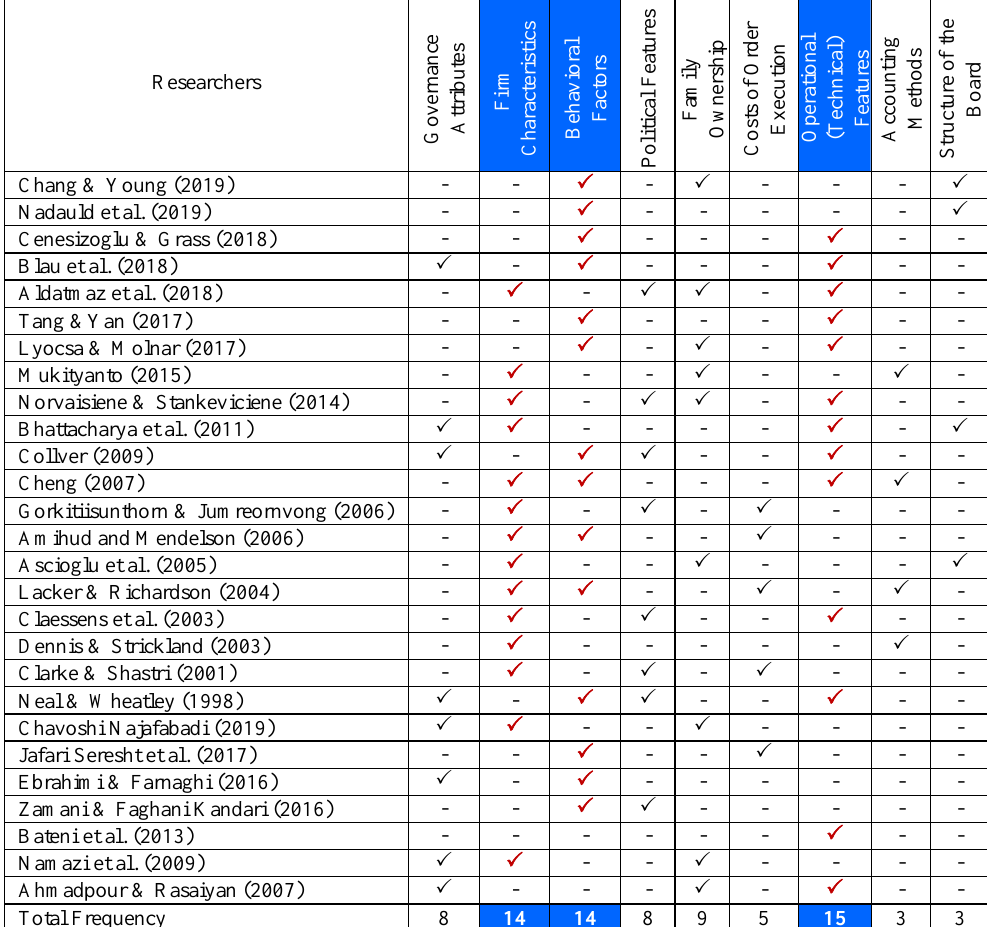
Table 3. Determining the Main Components of the